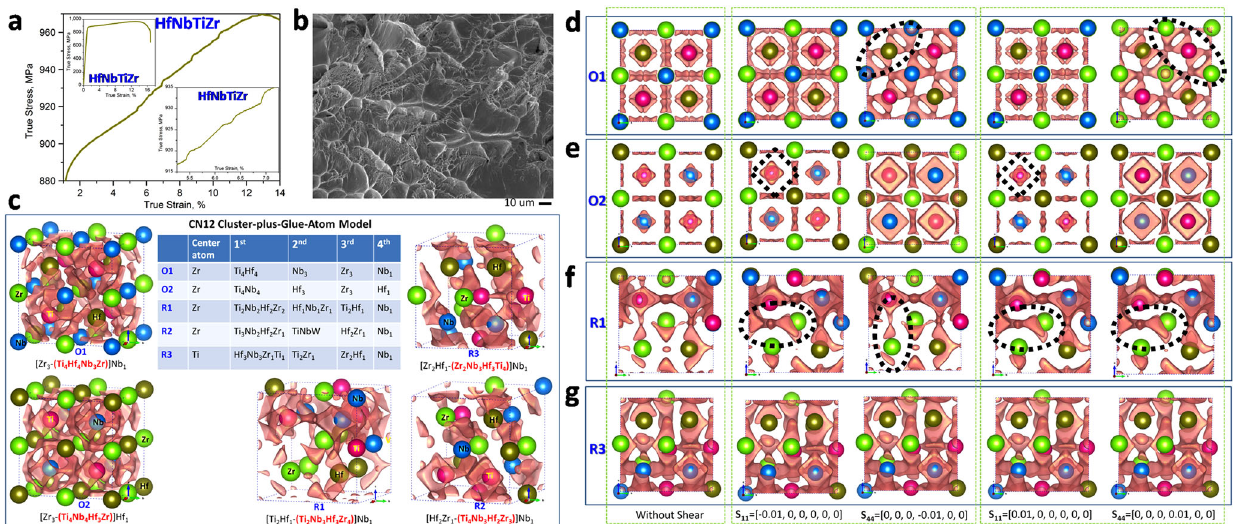
Fig. 4 Structure-dominated tensile property of the BCC HfZrTiNb HEA. a The stress – strain curve at a strain rate of 1 × 10 − 3 s − 1 during tensile testing. The various symbols present the corresponding stress states of the invested con fi gurations. b SEM image of the tensile fracture surface at room temperature, 298 K, representing a viscous- fl ow-dominated plastic-deformation behavior. c bonding-charge-density isosurface ( Δ ρ = 0.008 e − Å − 3 ) of con fi gurational transformations of ([Zr 3 -( Ti 4 Hf 4 Nb 3 Zr 1 )]Nb 1 ) (labeled as O1), ([Zr 3 -( Ti 4 Nb 4 Hf 3 Zr 1 )]Hf 1 ) (labeled as O2), [Ti 2 Hf 1 -( Ti 2 Nb 3 Hf 3 Zr 4 )]Nb 1 (labeled as R1), [Hf 2 Zr 1 -( Ti 4 Nb 3 Hf 2 Zr 3 )]Nb 1 (labeled as R2), and [Zr 2 Hf 1 -( Zr 2 Nb 3 Hf 3 Ti 4 )]Nb 1 (labeled as R3) structures in a 3D view. The insert table presents the details of the fi rst four nearest neighbors of the center atom. Atoms in the CN14 cluster are written in red letters. d – g (100) supercell view of the variations of the bonding-charge-density response to an elastic shear under anormal and shear strain ( ± 0.01). The dashed ellipses and diamonds highlight the response of Δ ρ to the elastic deformations. Plots of the Δ ρ isosurfaces that the relatively strong binding between elements from different transition metal groups of the periodic table and the relatively weak bonding between elements from the same group are formed. 33, 54, 55 Under an applied normal/shear strain, the electron redistributions are dominated by the local atomic arrangements, resulting in a difference in the electron tomography as shown in Fig. 2c – h. For example, under the compressive and tensile shear deformation, the bonding electrons around the Mo atoms in O1 and O2 con fi gurations present the opposite directions, which are highlighted by the dashed ellipses in Fig. 2d – e. Interestingly, under the normal compressive and tensile deformation, the ring- type bonds around Mo atoms in the O2 con fi guration transforms back to the octagon with half edges enriched of electrons, shown in Fig. 2e. Meanwhile, the dashed ellipses in Fig. 2f – h highlight the weak spots caused by the large lattice distortion near Mo atoms. In addition to the BCC MoNbTaW HEA, the serration behavior of the BCC HfNbTiZr HEA, but now under tension, is shown in Fig. 4a, together with an SEM image of a fracture surface (Fig. 4b), with the bonding-charge density isosurface of the investigated con fi gurations with/without the applied strains shown in Fig. 4c – g. Similarly, under the compressive and tensile shear deformation, the bonding electrons around the Ti atoms in the O1 con fi gura- tion present the opposite directions, which are highlighted by the dashed ellipses in Fig. 4d. The diamond-type bonds around the Ti atoms in the O2 con fi guration is shrunk during the applied stress changed from the normal compression to the tension, shown in Fig. 4e. As for the random solutions, i.e., the R1 con fi guration, the region-enriched Zr atoms form the weak spot, which is attributed to the largest atomic size of Zr than those of Hf, Nb, and Ti in the HfNbTiZr HEA, and thus, to result in a large lattice distortion. Under the normal and compressive tension and the compressive shear, the vertical bonding electrons around Zr atoms are changed horizontally, which are highlighted by the dashed ellipses in Fig. 4f. Moreover, through combining the predicted yield strengths of various con fi gurations into the stress – strain curve, the possible microstates related to their strains are addressed, which indicate that each con fi guration/microstate is